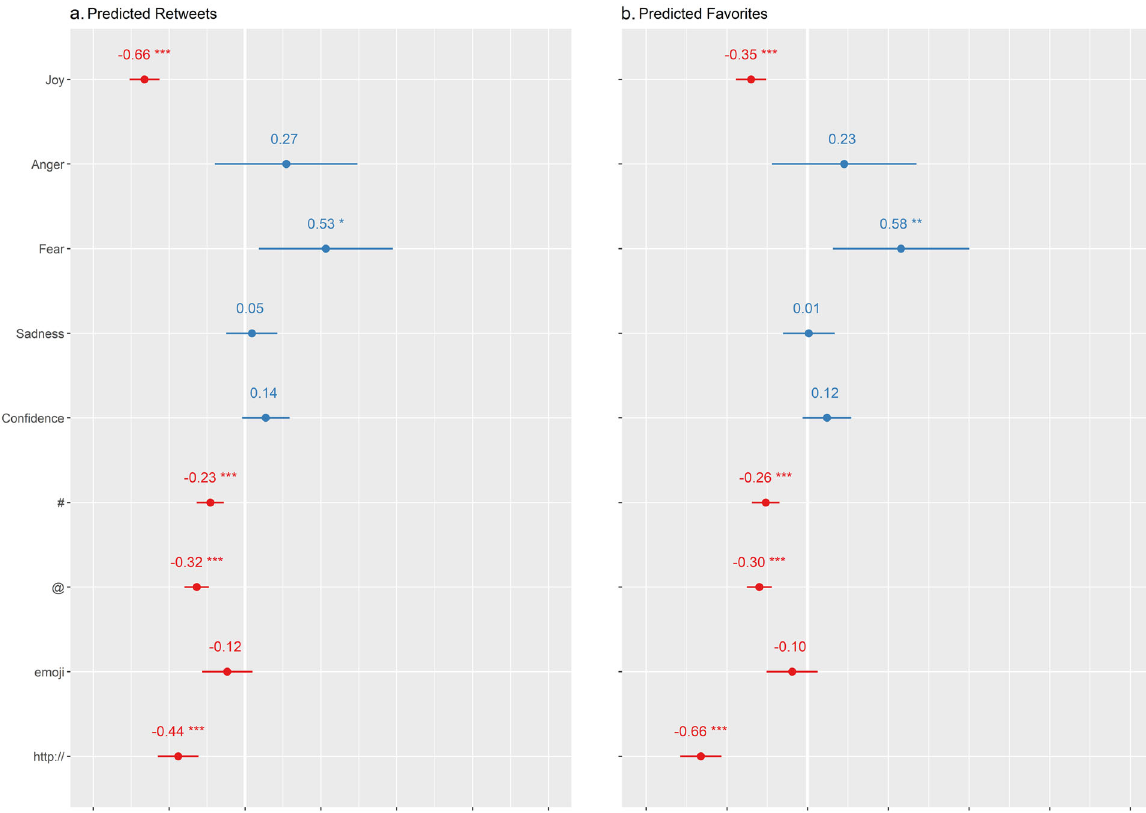
Fig. 3 Predicted effects on Twitter engagement among Democrats. Predicted effects on a retweet and b favorite counts leading up to the 2018 US mid- term elections (09 October – 06 November 2018) among Democrats. Conditional R 2 (0.744) Ω 2 and (0.765) measure the model ’ s variance between the observed and the predicted response. Recoded #, @, URL and emoji to dummy variables ( x = 1 for a given tweet contains the feature). Bands re fl ect 95% CIs with follower/friend counts, race competitiveness and incumbency as offset variables. * p < 0.05, ** p < 0.01, and *** p < 0.001 based on an F